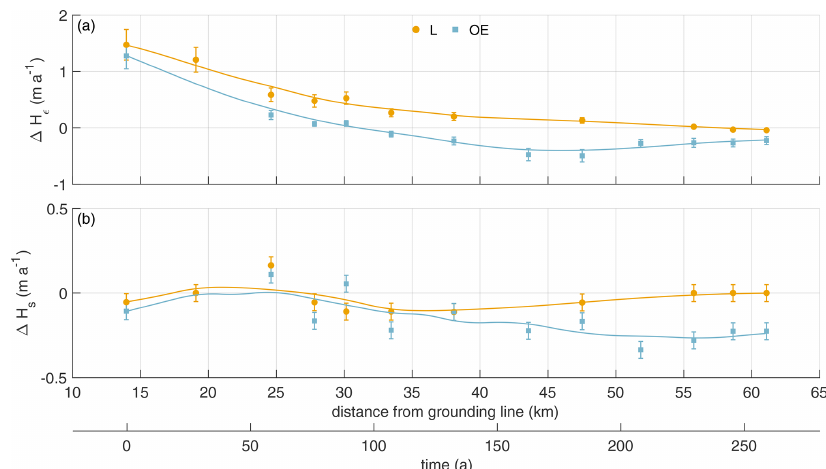
Figure A4. Distribution of pRES-derived (a) change in ice thickness due to strain and (b) ice thickness change due to surface process (firn compaction and accumulation) above the channel (yellow dots) and outside the east of the channel (blue squares). The solid lines represent a smoothed fit. Error bars mark the uncertainties of the pRES-derived